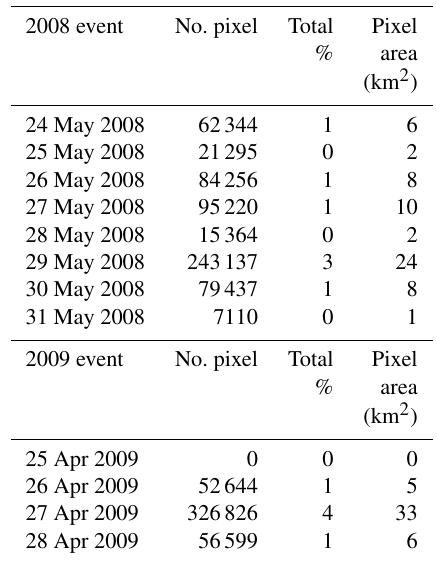
Table 4. HIRESSS results for both the 2008 and 2009 events. “No. pixel” represents the number of pixels with a slope failure probability over 75%; “Total%” represents the percentage of pix- els with slope failure probability over 75%; and “Pixel area (km 2 )” represents the extension of the area with slope failure probability over